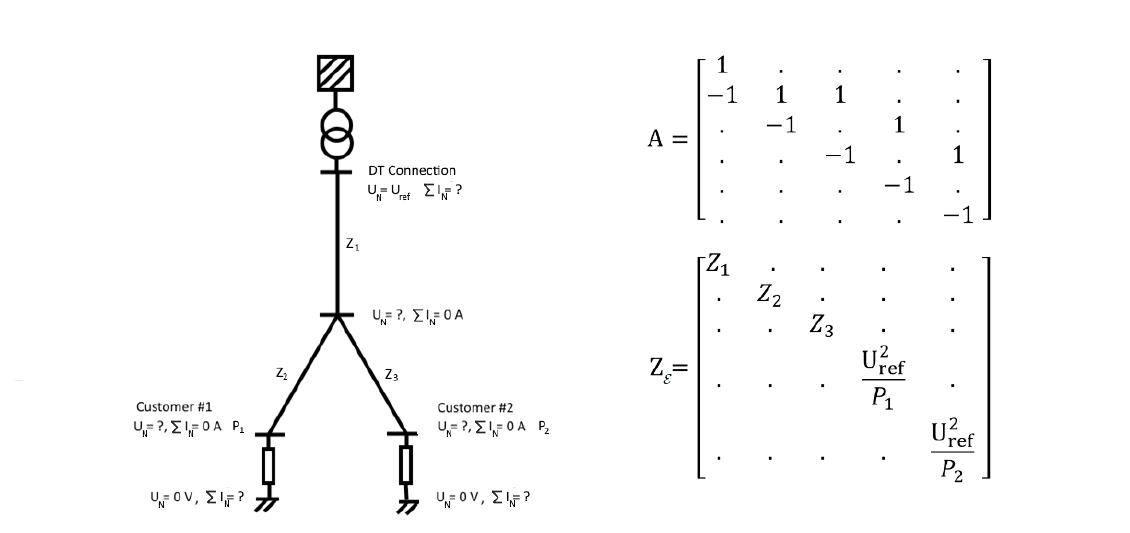
Figure 15. An example low=voltage distribution network ( left ) and its corresponding A and Z E matrices ( right